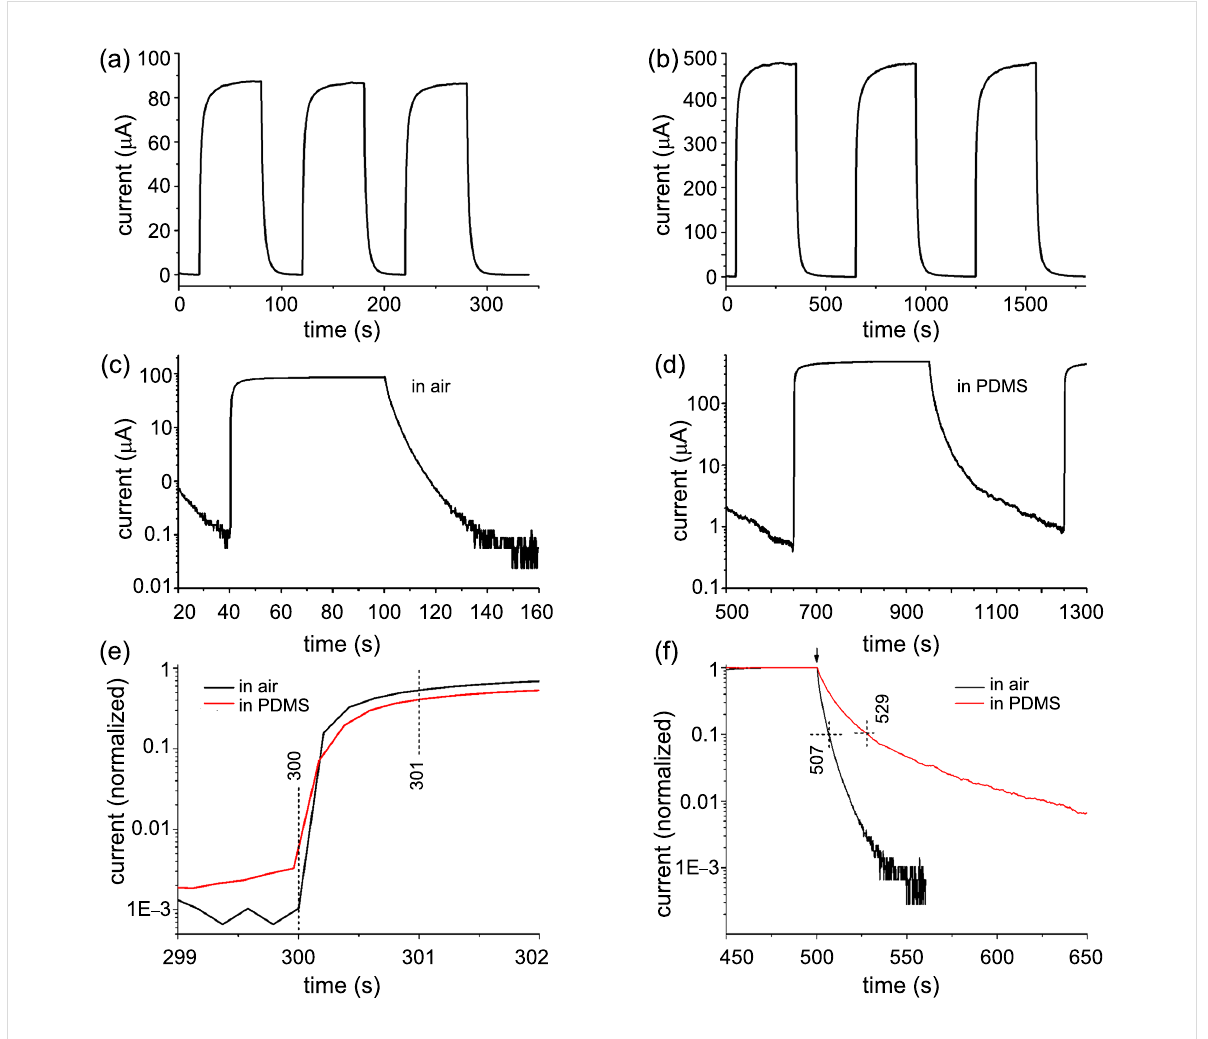
Figure 4: (a,b) UV photoresponse characteristics of ZnO nanowire sheets in air and in PDMS, respectively. The electrode of the device in air is vacuum-deposited Ti, and that of the device in PDMS is Ag–PDMS paste. The bias was set at 8 V for both devices; (c,d) UV photoresponse charac- teristics of the two devices with the current on a logarithic scale; (e and f) comparison of the UV-photocurrent rising and dark-current decay of the nanowire films in air and PDMS, respectively, with the current normalized by the